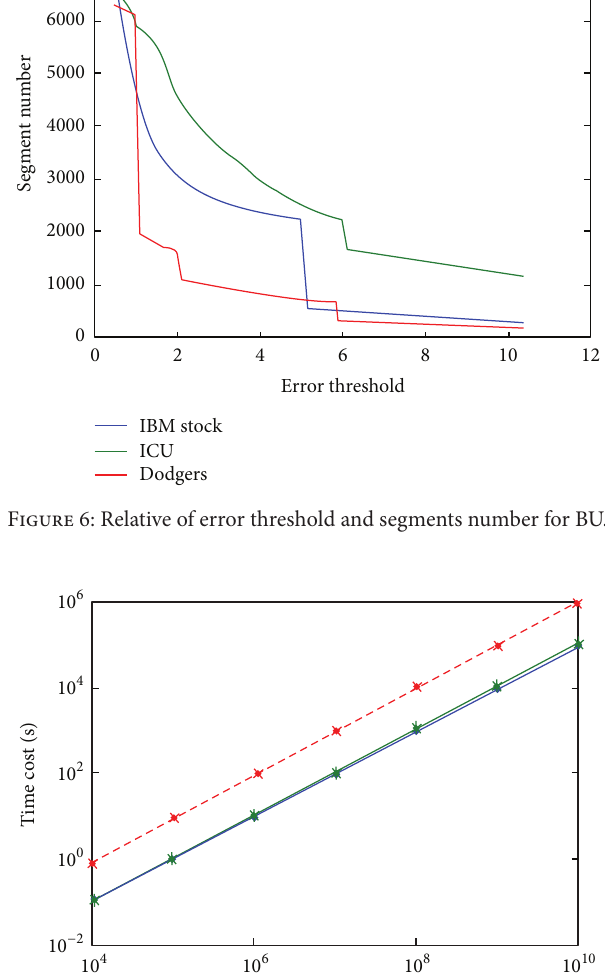
algorithm, but SWBU uses BU, an O ( n log n ) algorithm, as the base algorithm in slide window. With larger error rate threshold set, slower SWBU would run.